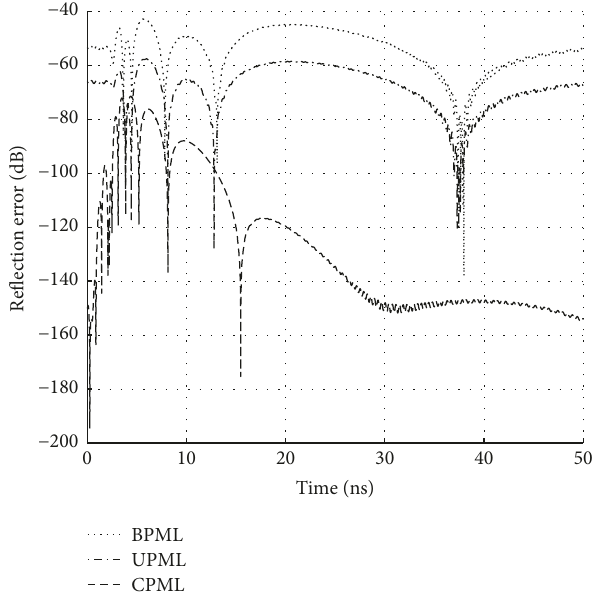
Figure 3: Reflection error in the electric field intensity relative to the field’s maximum amplitude versus time for BPML (with 𝐷 = 10 cells, 𝜎 max /𝜎 opt = 1, and 𝑚 = 4), UPML (with 𝐷 = 10 cells, 𝜅 max = 22, 𝜎 /𝜎 𝑚 = 4), and CPML (with 𝐷 = 10 cells, 𝛼 = 0.003, max opt = 1.2, and 𝜅 𝜎 /𝜎 𝑚 = 4) at point 𝑝 max = 72, max opt = 1.12, and